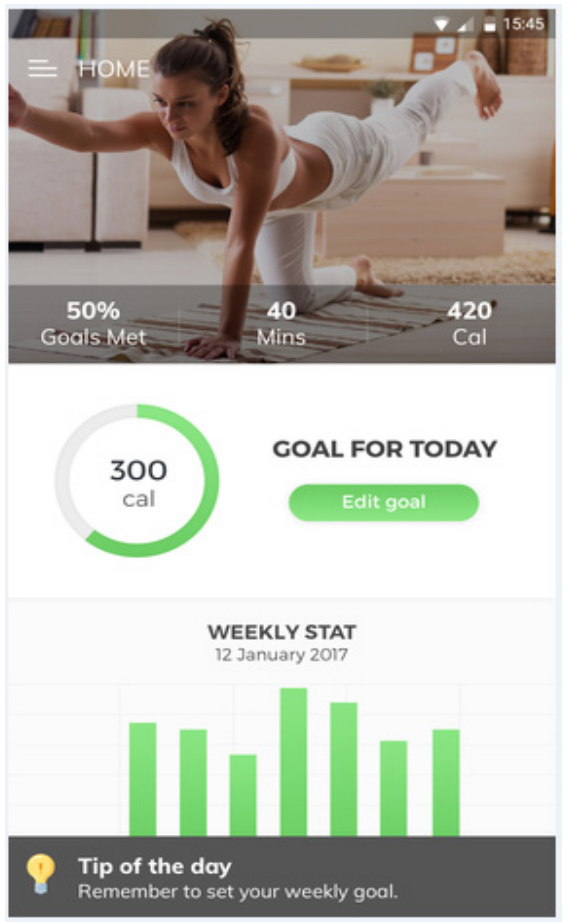
Figure 1. Homepage of fitness app prototype (Image of woman exercising retrieved from https://www.awaken.com/2016/09/home-yoga-practice-questions/, on September 4, 2021) [9]. The participants evaluated each of the four UX design attributes and the overall perceived persuasiveness of the fitness app prototype based on the homepage screen (only) shown in Figure 1. Moreover, we employed storyboards to illustrate the six persuasive features, which include Goal-Setting/Self-Monitoring, Reward, Cooperation, Competition, Social Comparison, and Social Learning. Figures A1–A6 (see the Appendix A) show screenshots of all six storyboards. The participants evaluated each of the storyboards by rating their level of receptiveness to each persuasive feature. In addition, the participants provided comments about each of the